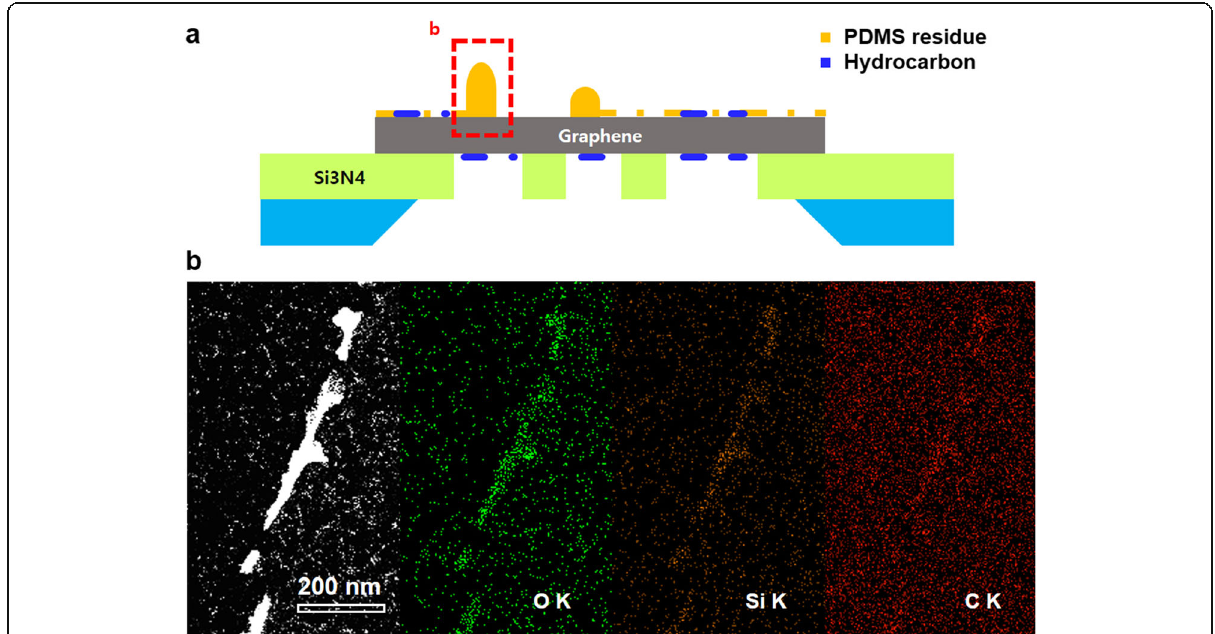
Fig. 3 EDX investigation of residue aggregation induced by mechanical sweeping. a Schematic side view showing PDMS residue aggregated by mechanical sweeping. b EDX mapping around the residue aggregation. HAADF-STEM, oxygen K edge, silicon K edge, and carbon K edge mapping images are shown from left to right